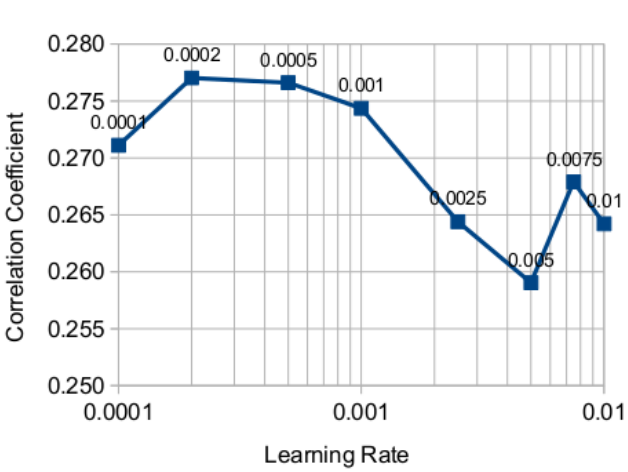
Figure A2. Semilog plot of the correlation coefficients for 10-fold cross-validation of the BRT model for forest conversion in the interval 2001–2011, with tree complexity equal to four and learning rates from 0.01–0.0001.